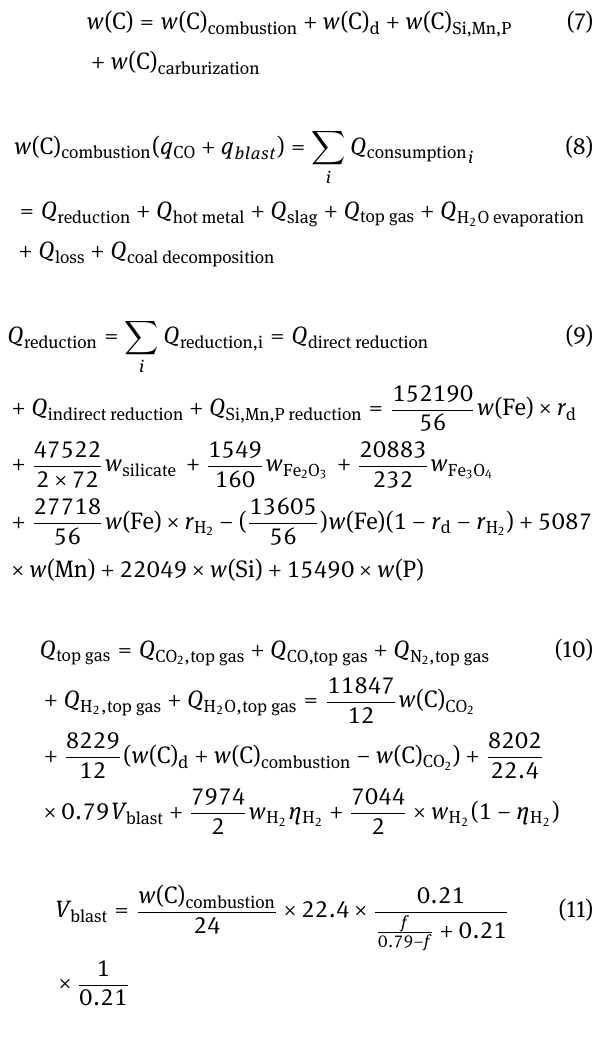
Table 3: Chemical composition of hot metal (mass%) Fe Si P